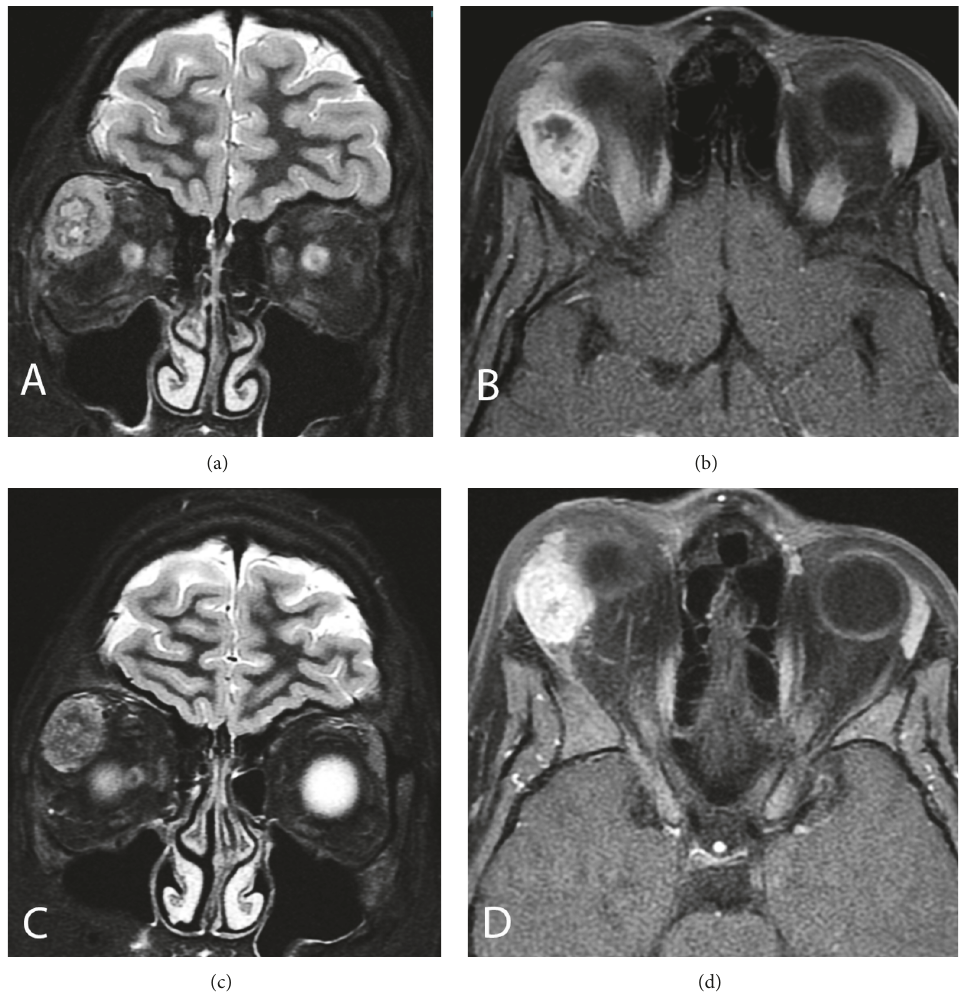
Figure1:CoronalT2-weightedMRimagerevealsaheterogeneousoval-shapedrightlacrimalglandmasswithlowandhighsignalscontaining solid and cystic components (a). Fat-saturated axial postcontrast MR image obtained at 20 months before the admission shows heterogeneous intense enhanced mass due to unenhancing cystic component (b). Coronal T2-weighted MR image shows a heterogeneous oval-shaped predominantly solid mass with low and high signals without a clear cystic component (c). Fat-saturated axial postcontrast MR image on admission shows almost homogeneous intense enhancement